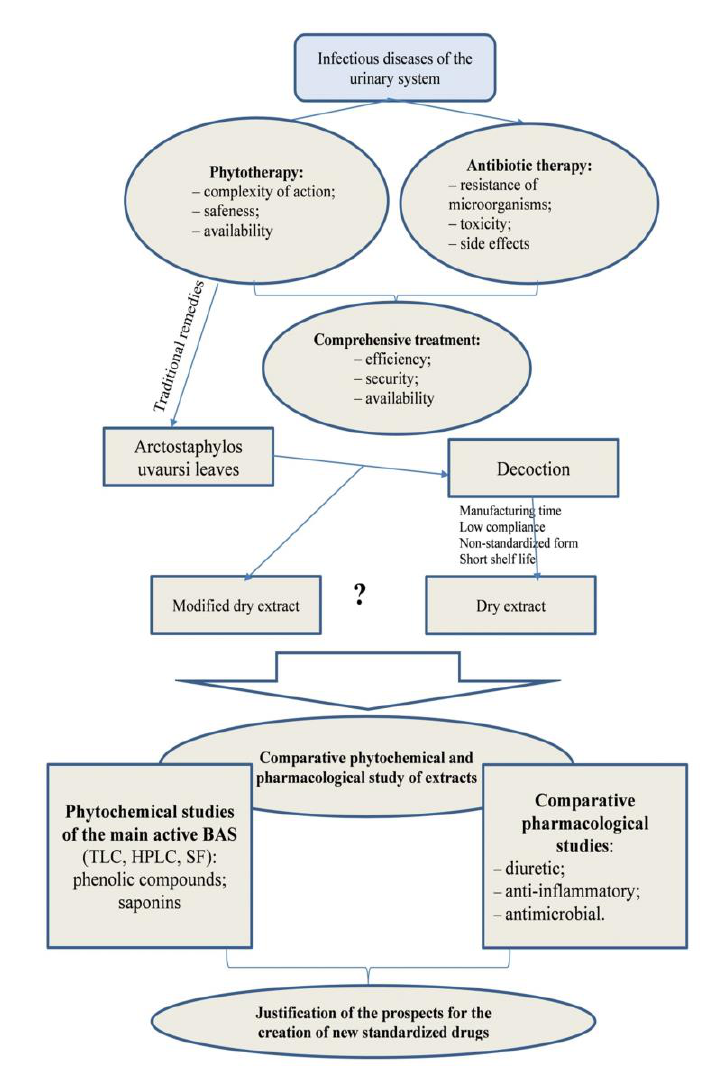
Fig. 1. Scheme of substantiation of relevance and planning of the experi- ment in the study of extracts of Arctostaphylos